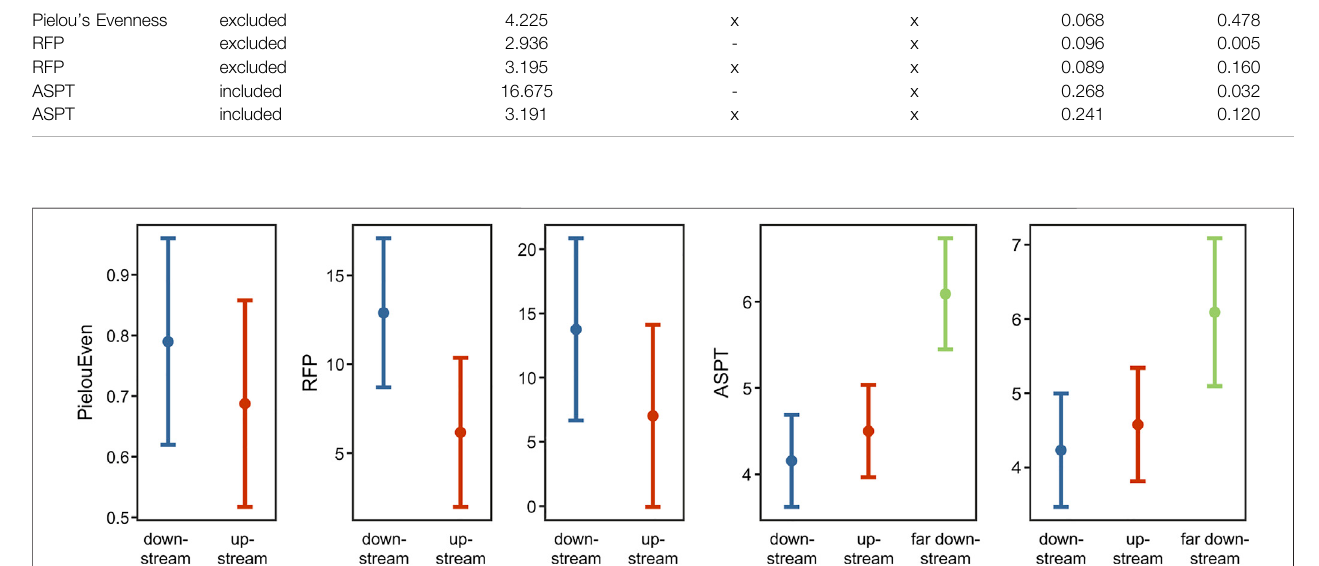
FIGURE 2 | Predicted values of the fi xed effects of the fi ve signi fi cant linear mixed effects models. The fi xed effects of the ASPT models show that the variance in both models is mostly contributed by the communities sampled further downstream of Dam II. ASPT, average score per taxon; RFP, rare family prevalence.